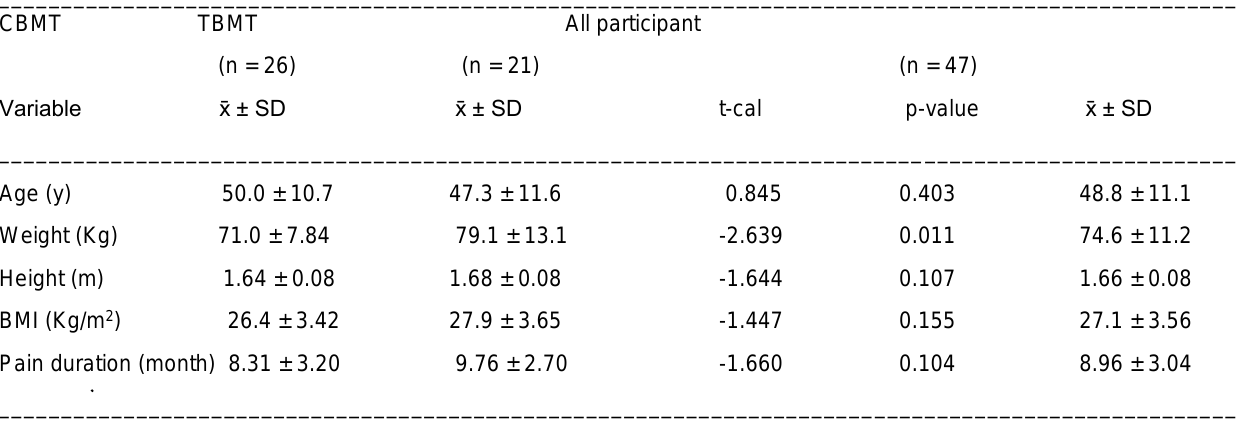
Table 1. Independent t-test Comparison of the Participants’ General Characteristics by Treatment Groups